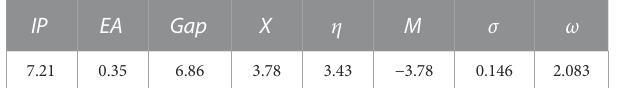
TABLE 9 Calculated GRPs for the isomer 5 ( eV